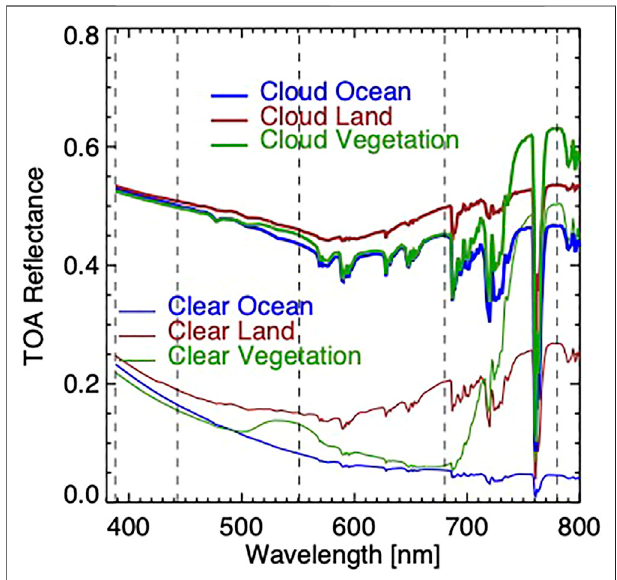
FIGURE 6 | TOA spectral re fl ectance simulated using SBDART (Ricchiazzi et al., 1998) for clear and cloudy atmospheric conditions over ocean, land, and vegetation. The cloud optical depth is 10, and solar zenith angle is 30 ° . The vertical dashed lines indicate the EPIC wavelengths.